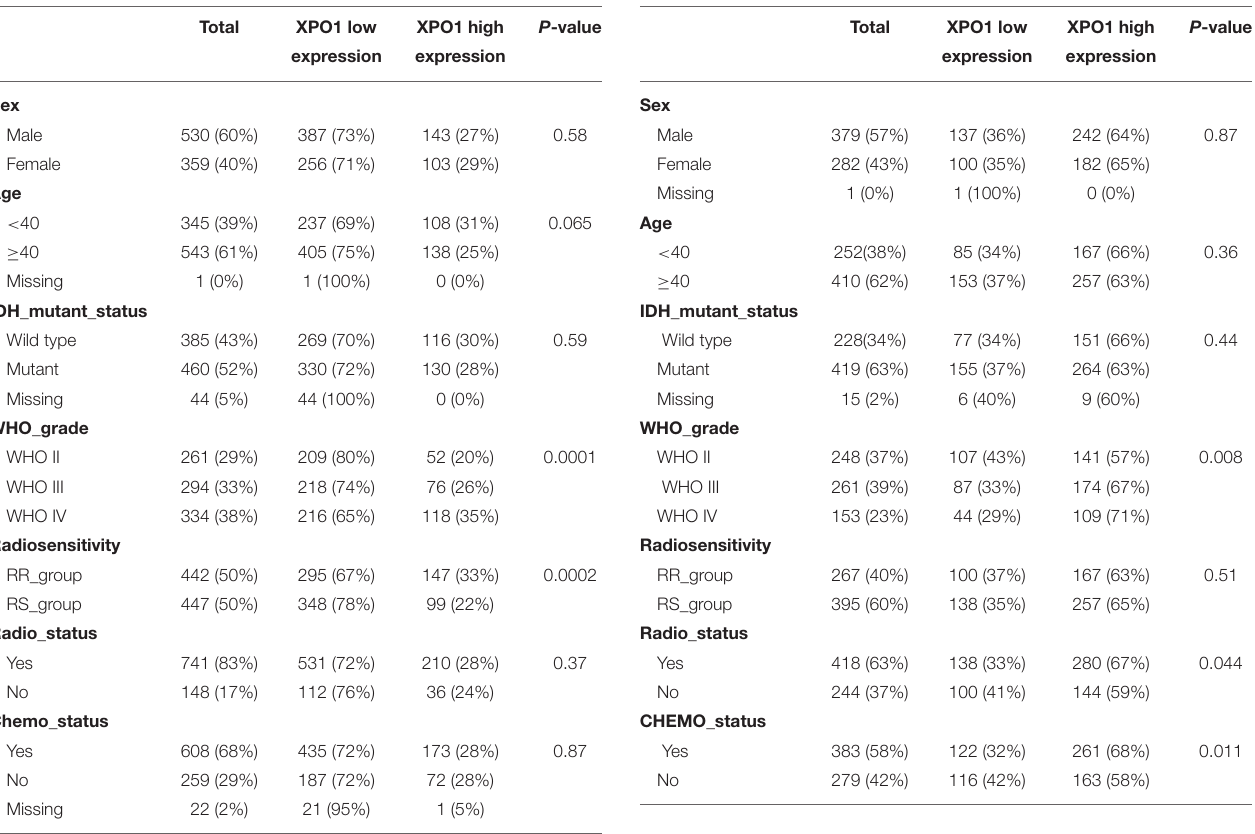
TABLE 2 | Demographics and clinicopathologic characteristics for glioma patients in the TCGA